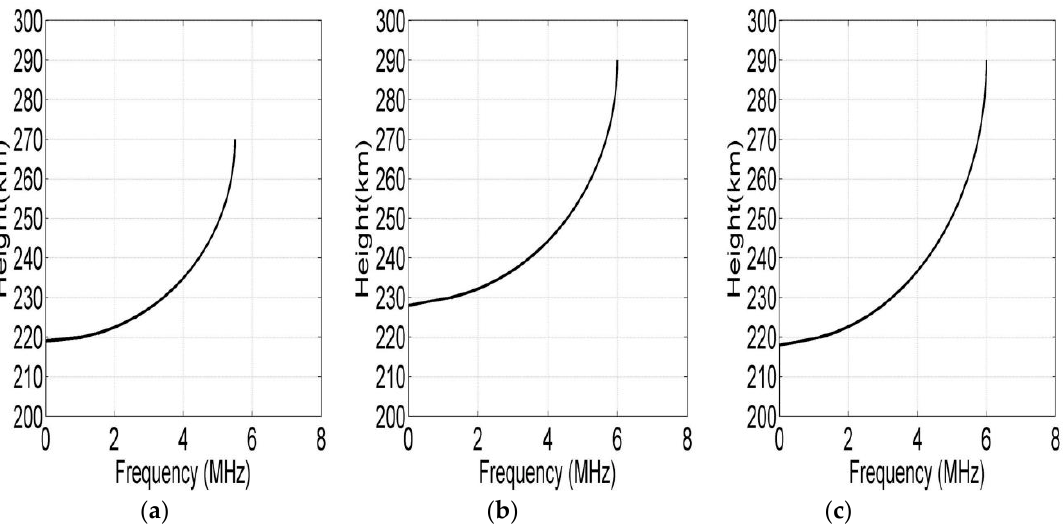
Figure 8. Inversion results of oblique ionograms: ( a ) is the electron density profile inversed from the oblique ionogram of the Leshan-Ningqiang channel. ( b , c ) are the electron density profiles of Leshan-Wuhan and Wuhan -Ningqiang.